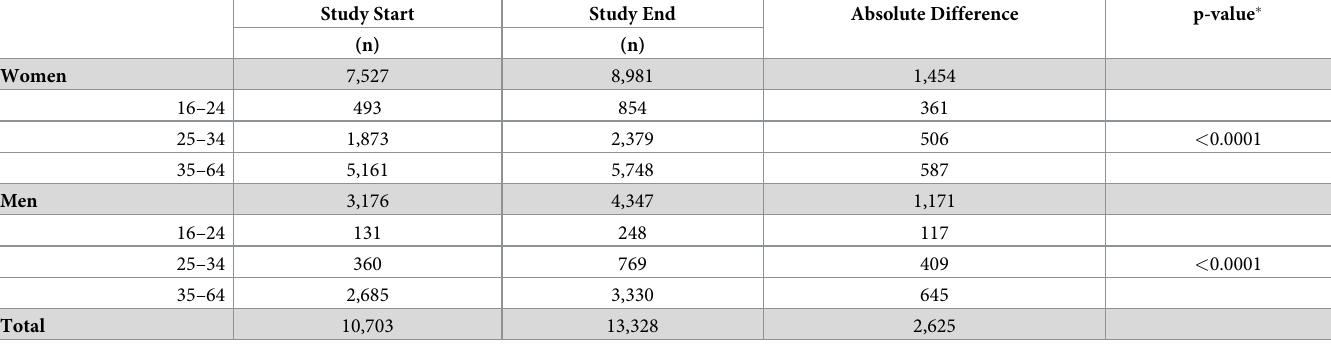
Total 2,625 n, number of participants � Rao-Scott Chi-Square test for difference in knowledge at study start and study end; �� Significant at α = .05